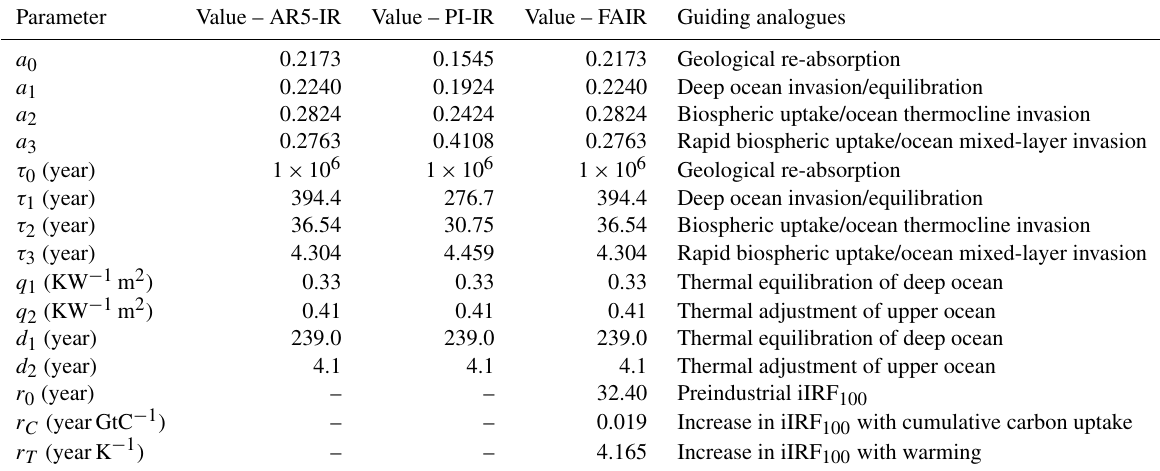
Table 1. Default parameter values for the simple impulse-response climate–carbon-cycle models used in this paper. Parameter